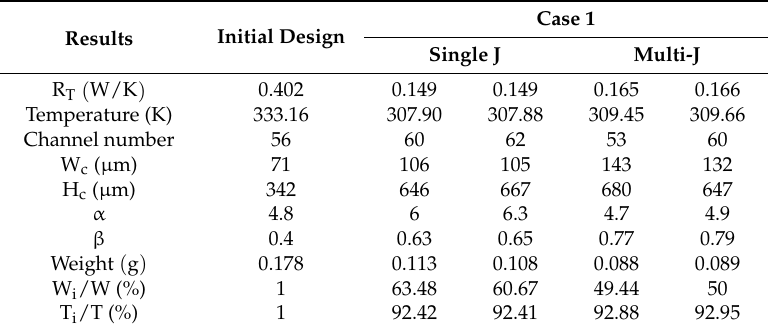
Table 5. Optimal results of the single and multi ‐ objective function in Case 1.